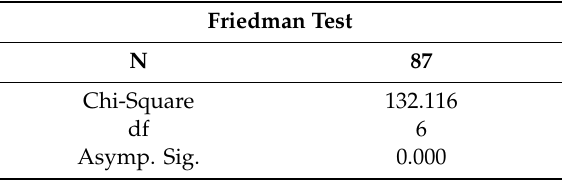
Table 10. Friedman test: Perception of the importance of selected Green Logistics